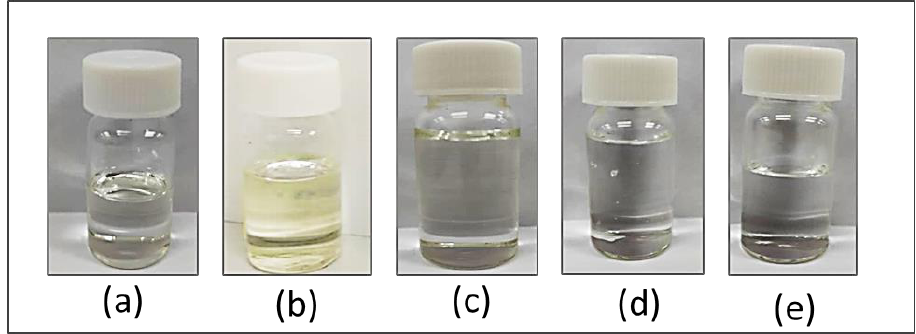
Figure 2. Hydrophobic DESs are obtained when menthol and various fatty acids ( a ) propanoic acid, ( b ) butanoic acid, ( c ) hexanoic acid, ( d ) octanoic acid, and ( e ) decanoic acid are combined in an equimolar ratio of 1:1.